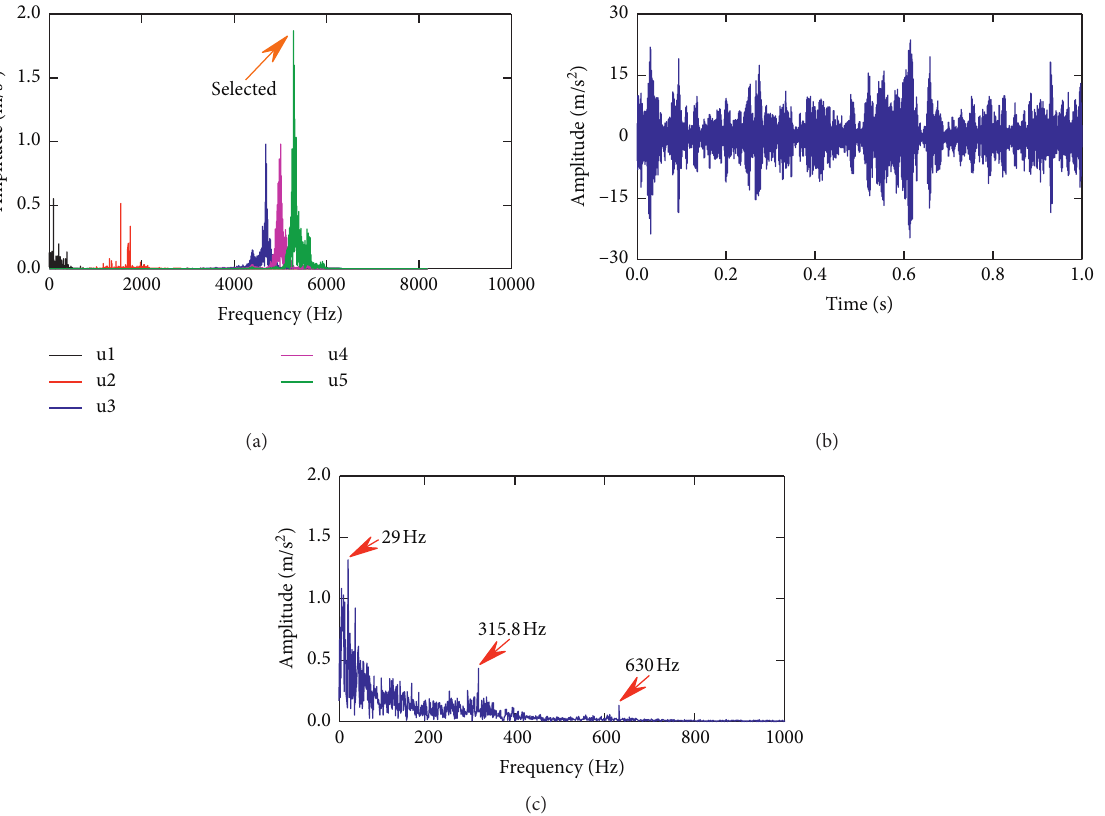
Figure 22: Analysis results of experimental signals by the VMD method with k � 5 and α � 2000: (a) frequency spectrum of the five decomposed modes; (b) time-domain spectrum of mode u5; (c) envelope spectrum of mode